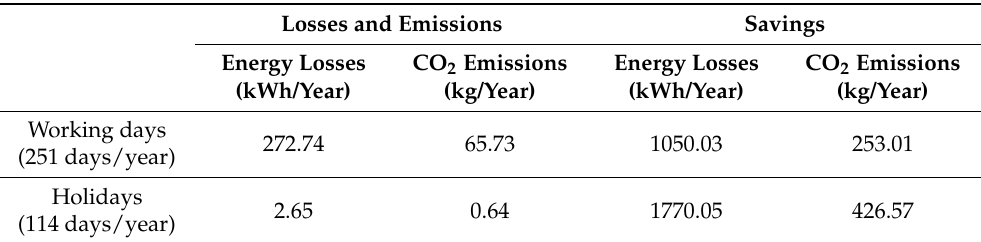
Table 9. Annual energy losses ( W (cid:48) cr ) and CO 2 emissions caused by reactive currents and savings after optimizing the operation of the capacitor bank Q c 2 .